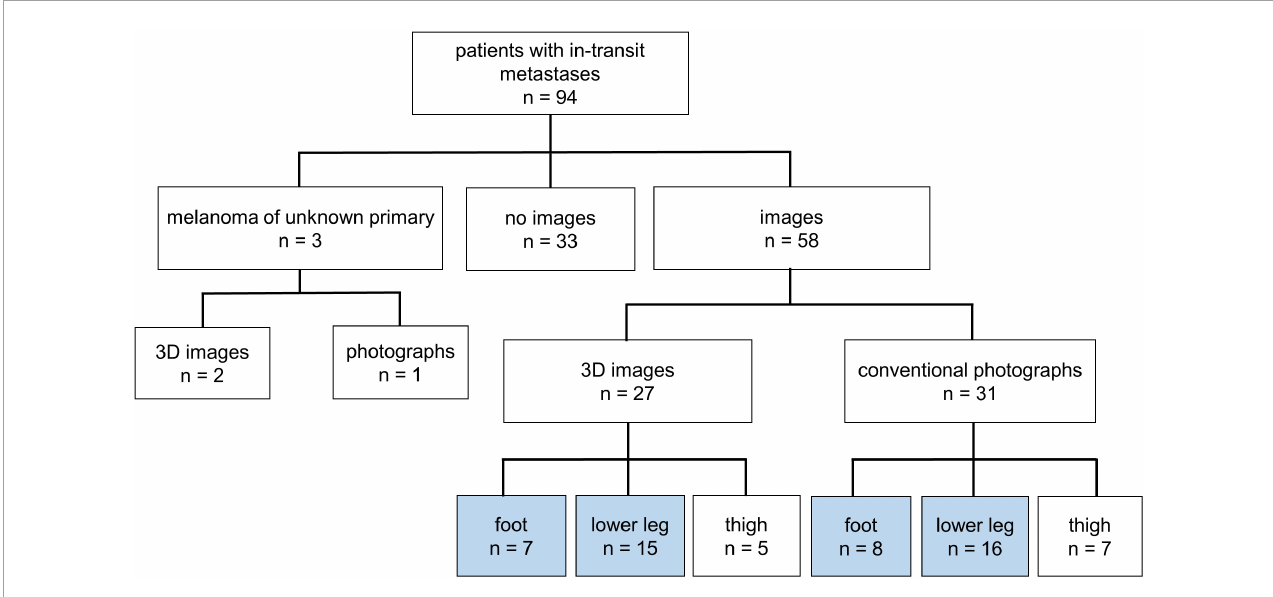
FIGURE1 Overview of melanoma patients with in-transit metastases ( n = 94) of the lower extremity. Definition of patients with available images taken by conventional or three-dimensional (3D) photography of the upper leg, lower leg, and